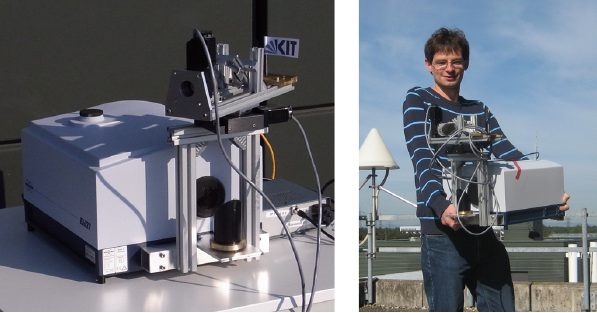
Fig. 1. The EM27 Spectrometer with the attached tracker. Right panel: transportation to the roof of the building where the measure- ments were